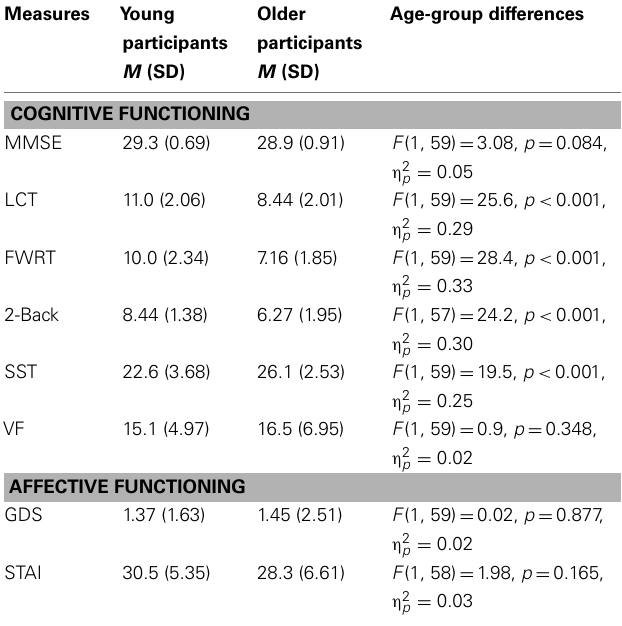
Table 2 | Means ( M ) and standard deviations (SD) and age-group differences for cognitive and affective